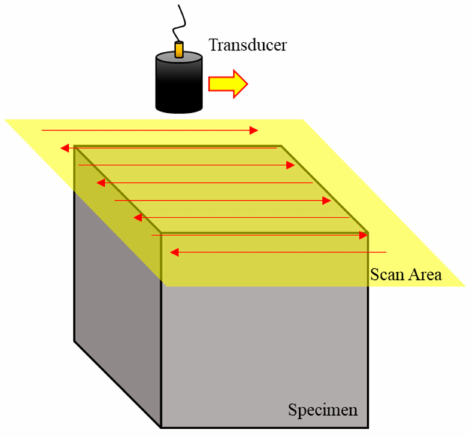
Figure 3. Experimental setup for the coupon specimen using the pulse-echo method.